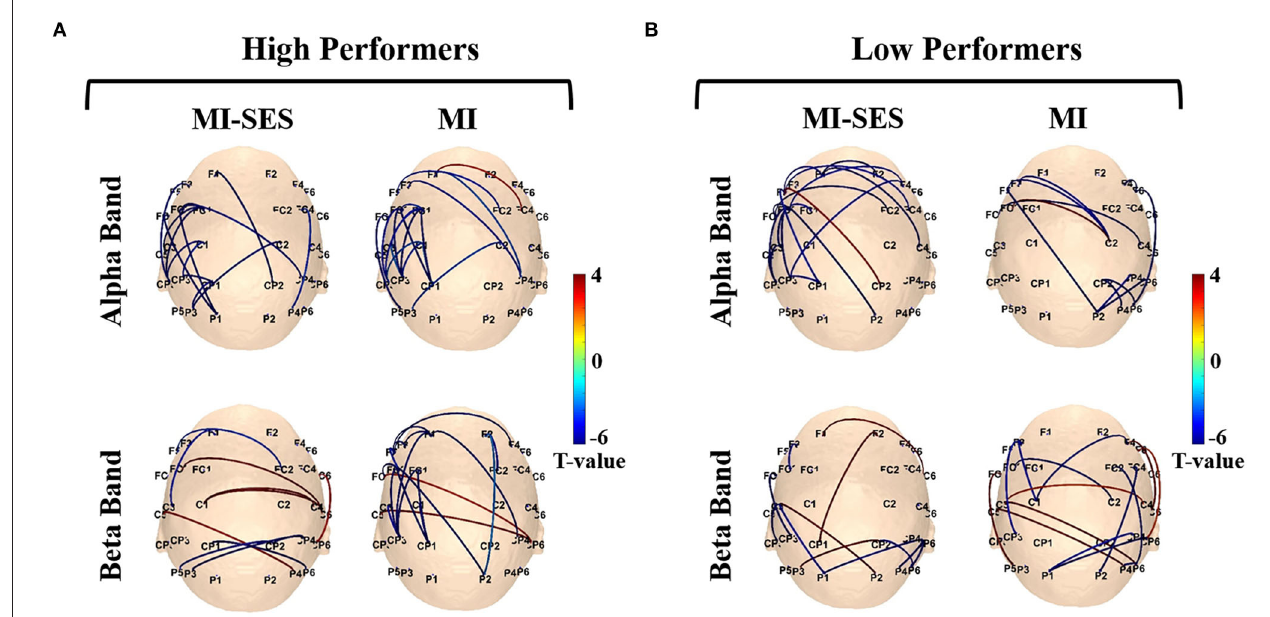
FIGURE 8 | The connectivity networks of alpha and beta rhythms for MI-SES and MI conditions. (A) High Performers group. (B) Low Performers group. The line between channels represents functional connectivity with significantly different wPLI values between MI and resting